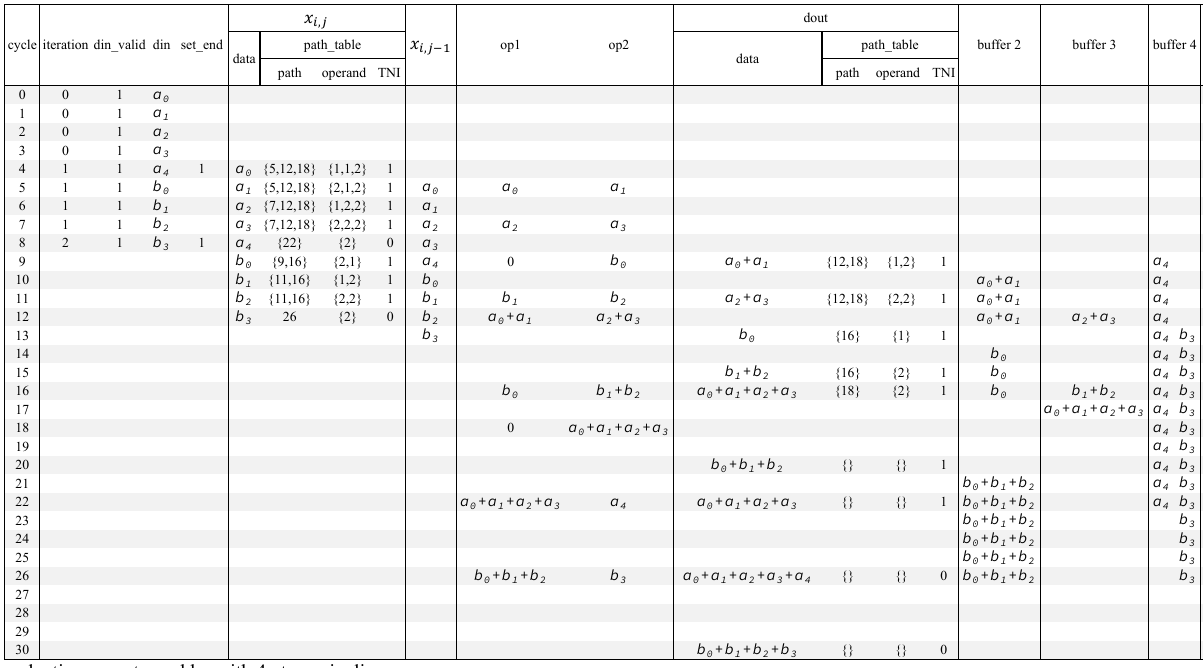
reduction operator: adder with 4-stage pipeline unit.TNI: For the sake of simplicity, the registers used to delay one clock cycle are included in the buffer 2 and buffer 3, and the elements of the same column in the buffer 2 and buffer 3 does not mean that they are cached in the same physical Figure 11. An example to show how BTPP hardware works. The reduction operator used is an adder with 4-stage pipeline, a i and ∑ 3 b i and the calculation tasks are ∑ 4 i = 0 i = 0